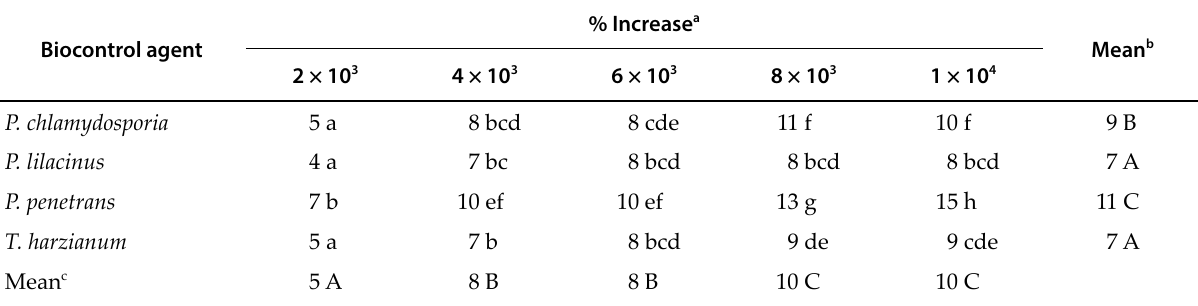
Table 2. Mean proportional increases in shoot dry weights of okra plants after treatments with different nematode biocon - trol agents applied at different propagule